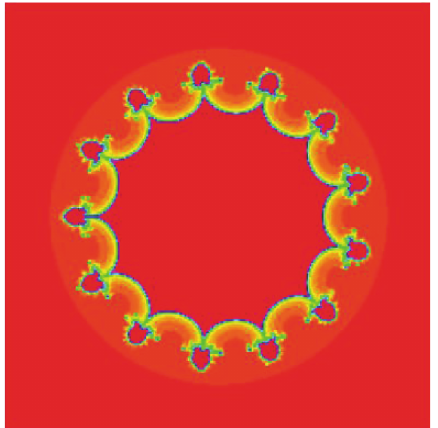
Figure 23: Relative superior multicorn for 𝑠 = 0.3 , 𝑠 󸀠 = 0.6 , and 𝑛 = 12 .